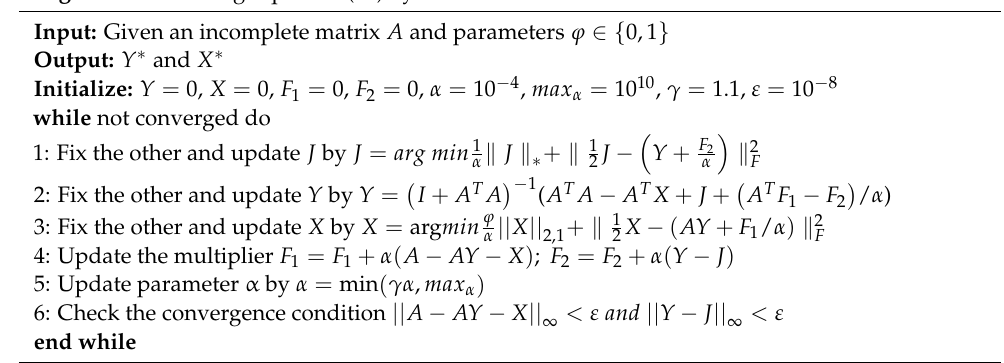
Algorithm 1: Solving Equation (21) by